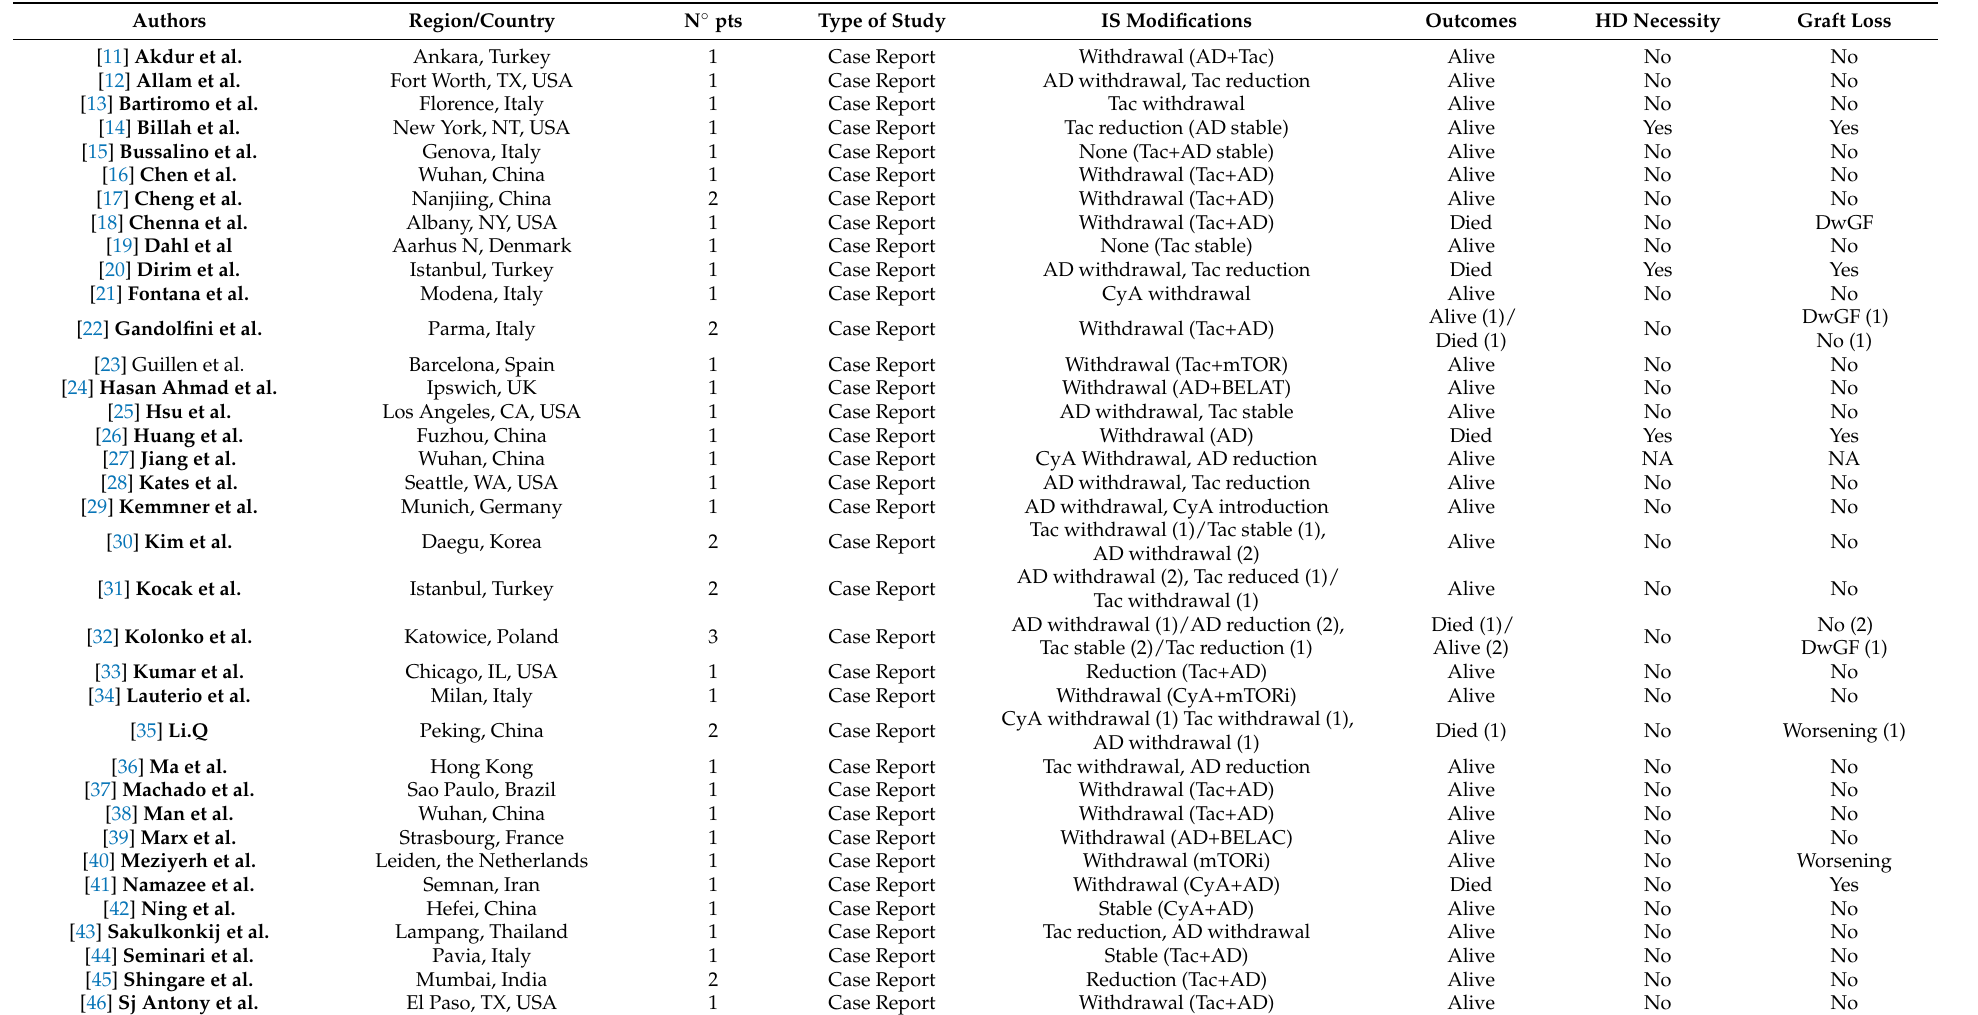
Table 1. Case reports of kidney transplant recipients infected with severe acute respiratory syndrome coronavirus 2 (SARS-CoV-2) included in the